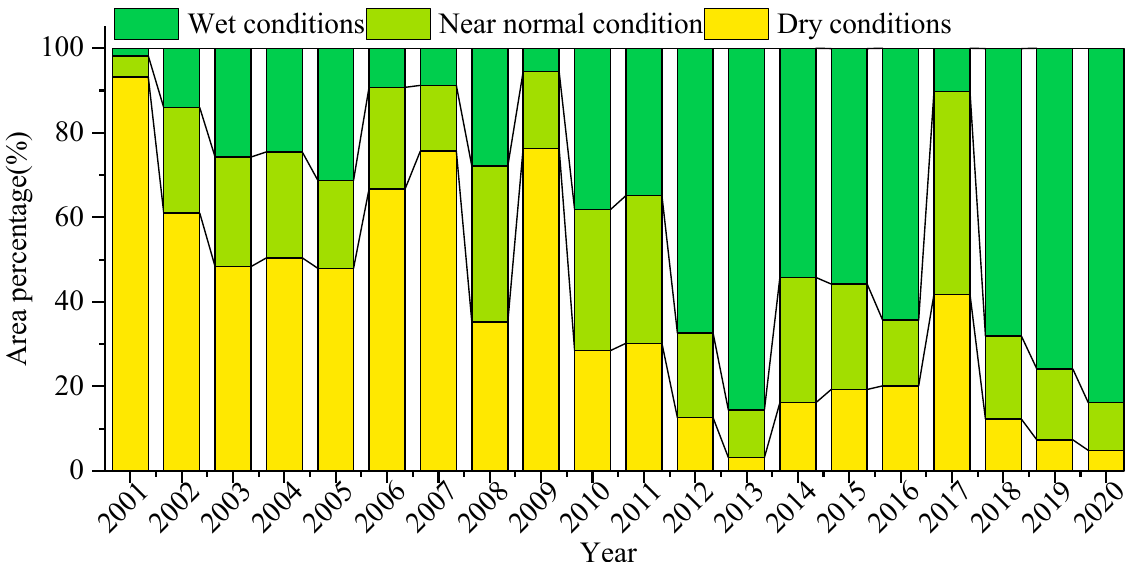
Figure 3. Percentage of change in dry, wet, and near-normal areas in Inner Mongolia from 2001 to 2020.